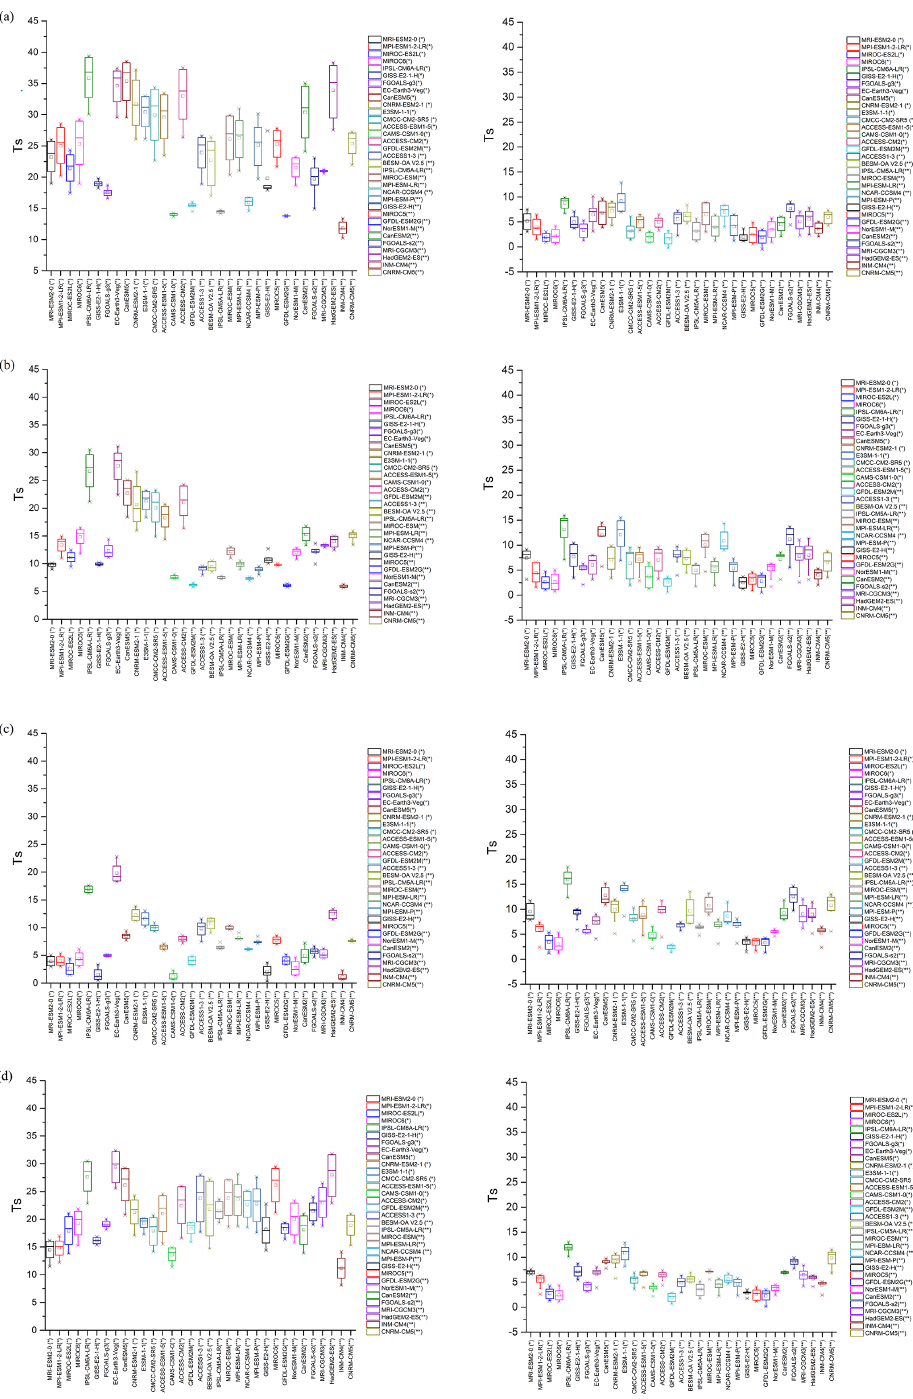
Figure 3. Seasonal zonal mean surface temperature differences ( K ) for the last 30 years of the Abrupt-4 × CO 2 numerical experiment minus the last 30 years of the piControl run for the CMIP5 and CMIP6 models; box plot in 75–90 ◦ N (left) and 60–80 ◦ S (right) for (a) winter (DJF), (b) spring (MAM), (c) summer (JJA) and (d) fall